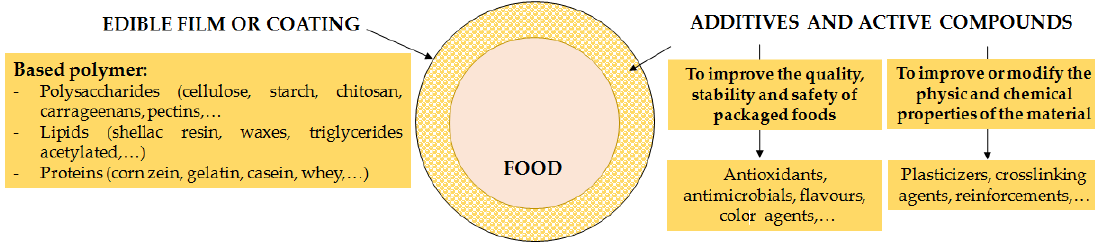
Figure 1. Edible films’ and coatings’ compositions.